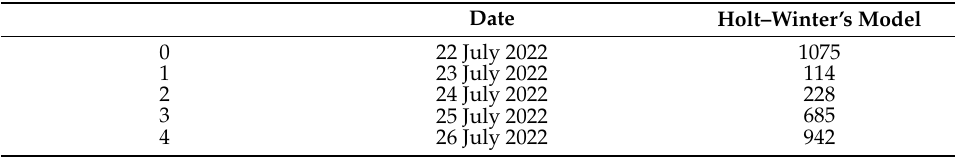
Table 4. Holt–Winter’s model confirmed case prediction over five Table 4. Holt – Winter ’s model confirmed case prediction over five days.